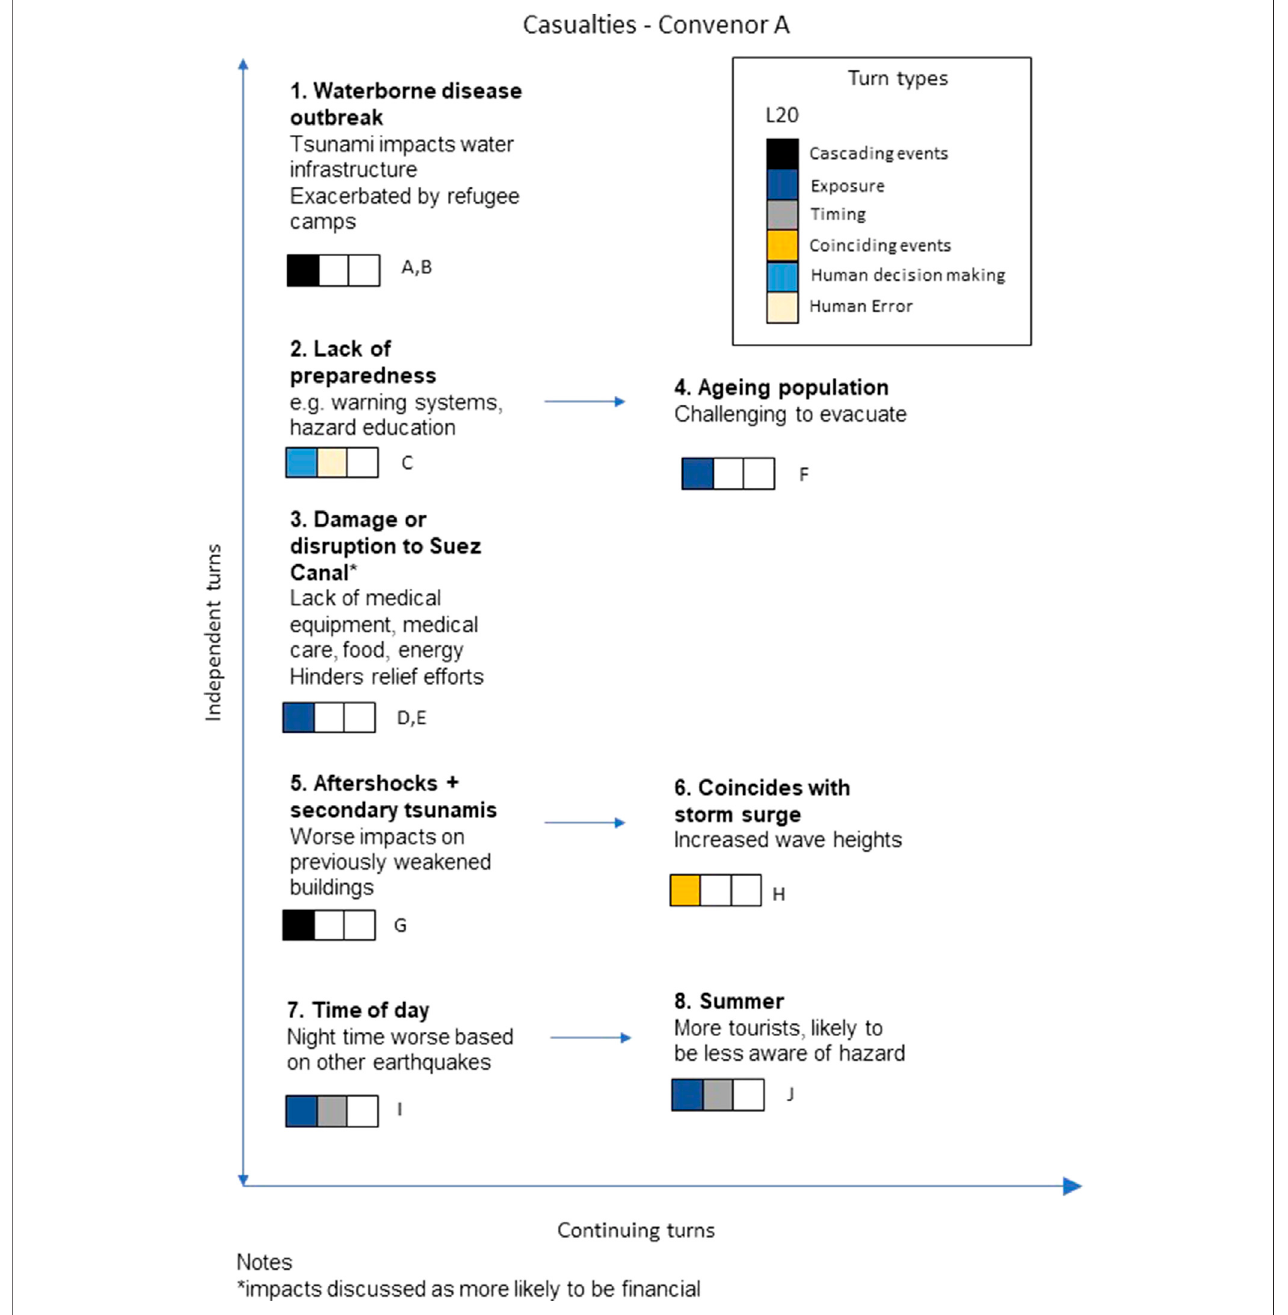
FIGURE 4 | Example scenario building exercise based on the casualties round. Turns are numbered in the order in which they were made. The vertical axis shows turns which are independent i.e., don ’ t follow on from each other, or didn ’ t in the context of the conversation. Arrows and x axis show turns which follow from previous ones. The three coloured blocks beneath each turn show the Lin et al. (2020) turn type(s) with which the turn was coded ‘ L20 ’ in the letters refer to turns identi fi ed as repeated: A – waterborne disease outbreak, B – damage to water infrastructure, C – lack of (timely) warning, D – damage to Suez Canal, E – food shortages, F – ageing population, G – aftershock, H – coinciding storm, I – time of day, J – season (see other diagrams in Supplementary Material S3 ).